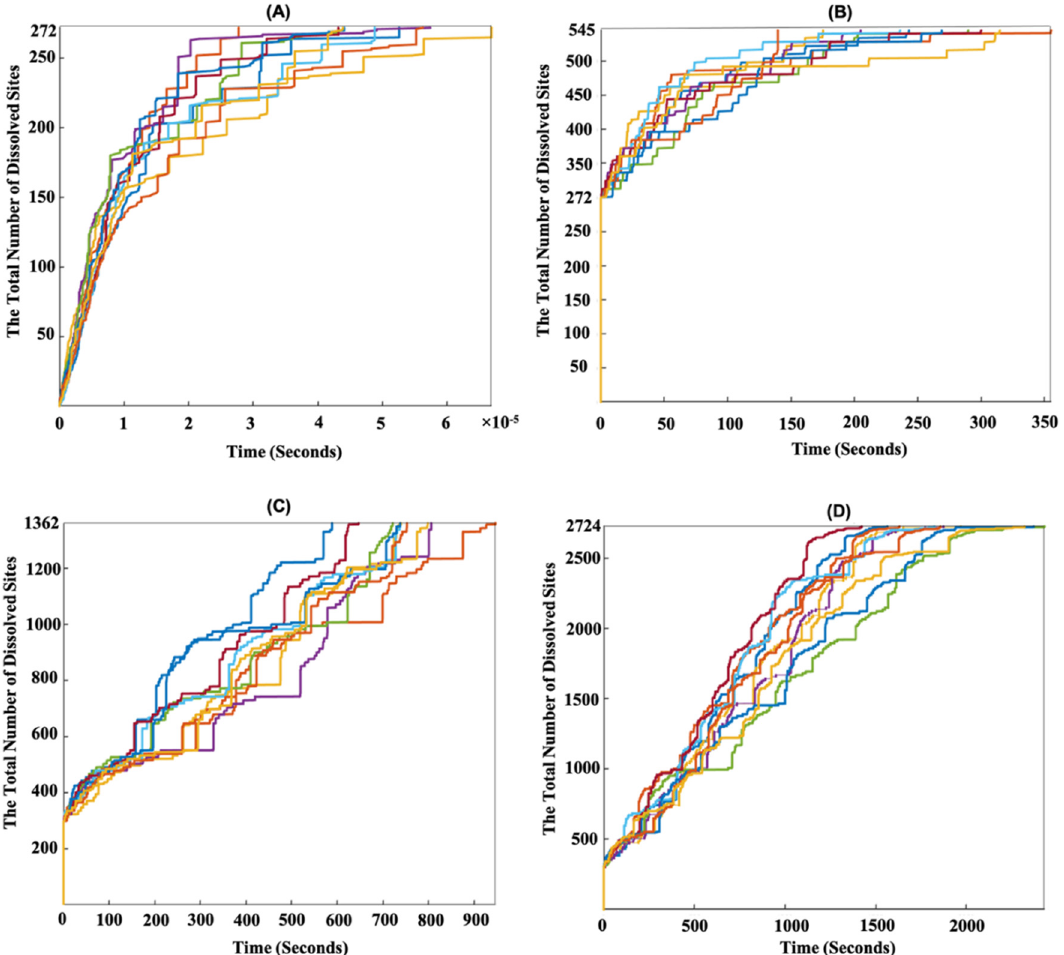
Figure 4. Time evolution of site dissolution for the β -C 2 S crystal by applying periodic boundary condition (PBCs) along the Y and Z axes for 10 numerical realizations (displayed with different colors) on the (100) and (100 ) facets. ( A – D ) After dissolution of 272, 545, 1362, and 2724 sites, the crystal had dissolved by 10%, 20%, 50%, and 100% of the total number of crystal sites of the initial structure, respectively.